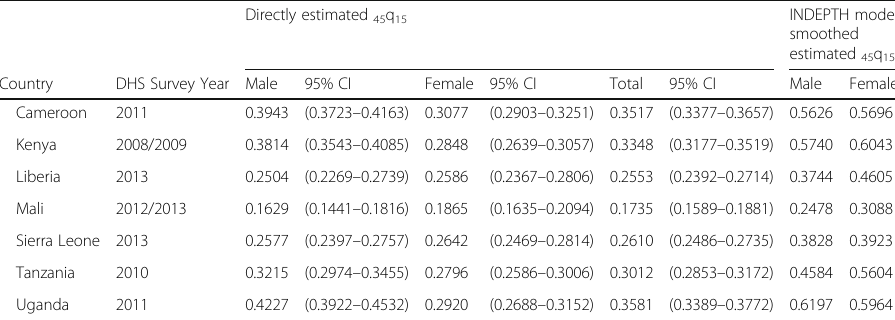
smoothed estimated 45 q 15